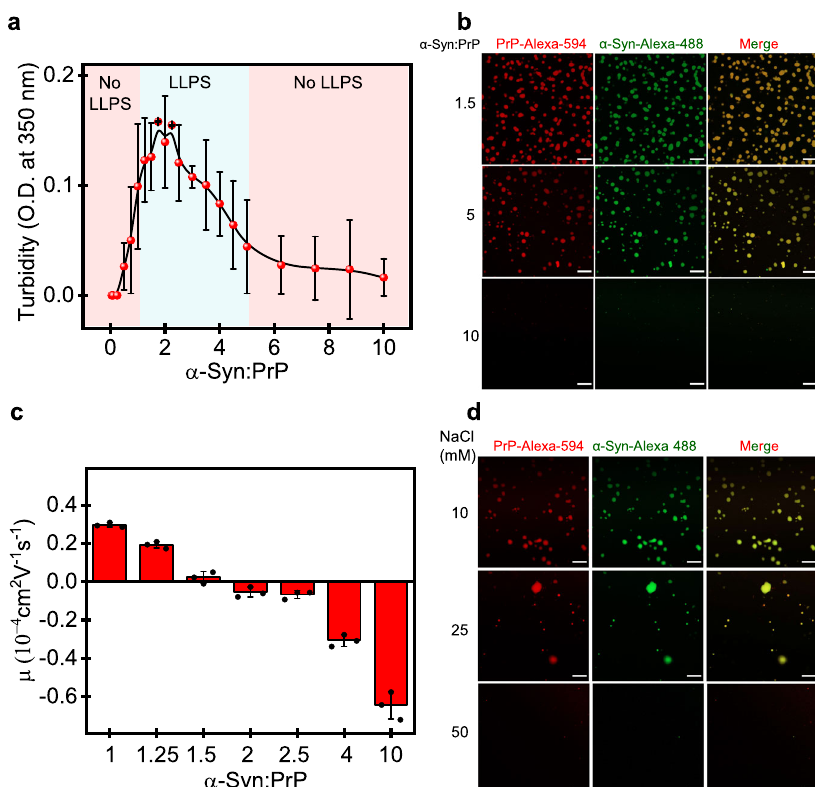
Fig. 2 Charge neutralization drives heterotypic LLPS of α -Syn and PrP. a Solution turbidity plot at fi xed PrP concentration (20 µ M) as a function of increasing α -Syn concentrations showing reentrant phase behavior. The data represent mean ± s.d. for n = 4 independent experiments. The solid line is for eye guide only. b Confocal microscopy images of Alexa-594-labeled PrP (red) and Alexa-488-labeled α -Syn (green) at different stoichiometries as indicated. Scale bar: 10 µ m. c Electrophoretic mobility ( µ ) measurements reveal charge inversion with the increase in the α -Syn:PrP ratio. The data represent mean ± s.d. for n = 3 independent experiments (corresponding data points are shown using black dot plots). d Confocal images of Alexa-594- labeled PrP (20 µ M) and Alexa-488-labeled α -Syn (30 µ M) droplets with increasing salt concentrations. Scale bar: 10 µ m. The imaging was performed thrice with similar observations ( b , d ). Source data are provided as a Source Data fi